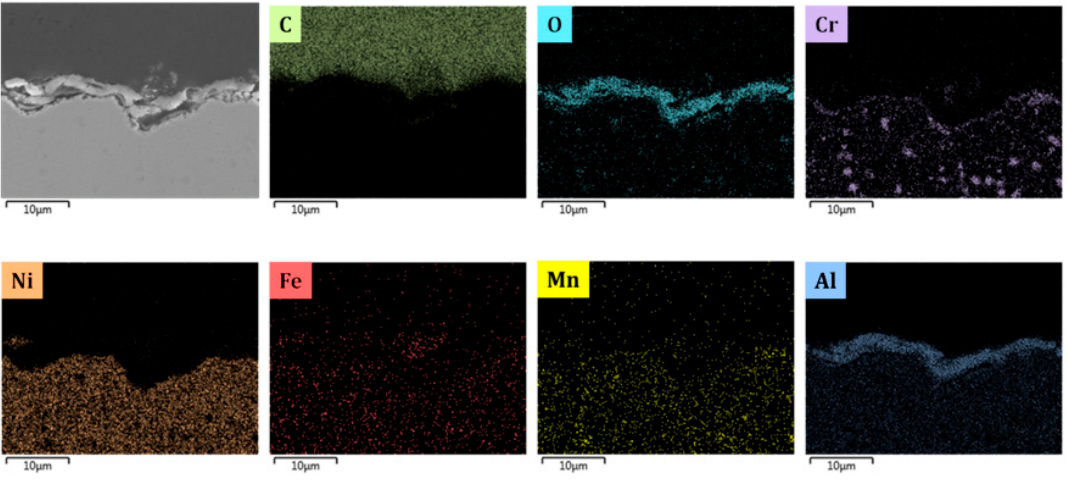
Figure 8. Cross-sectional elemental mapping of a CoatAlloy™ sample subjected to 14 h nitration. Magnification: 3000 ×, accelerating voltage: 15 kV .